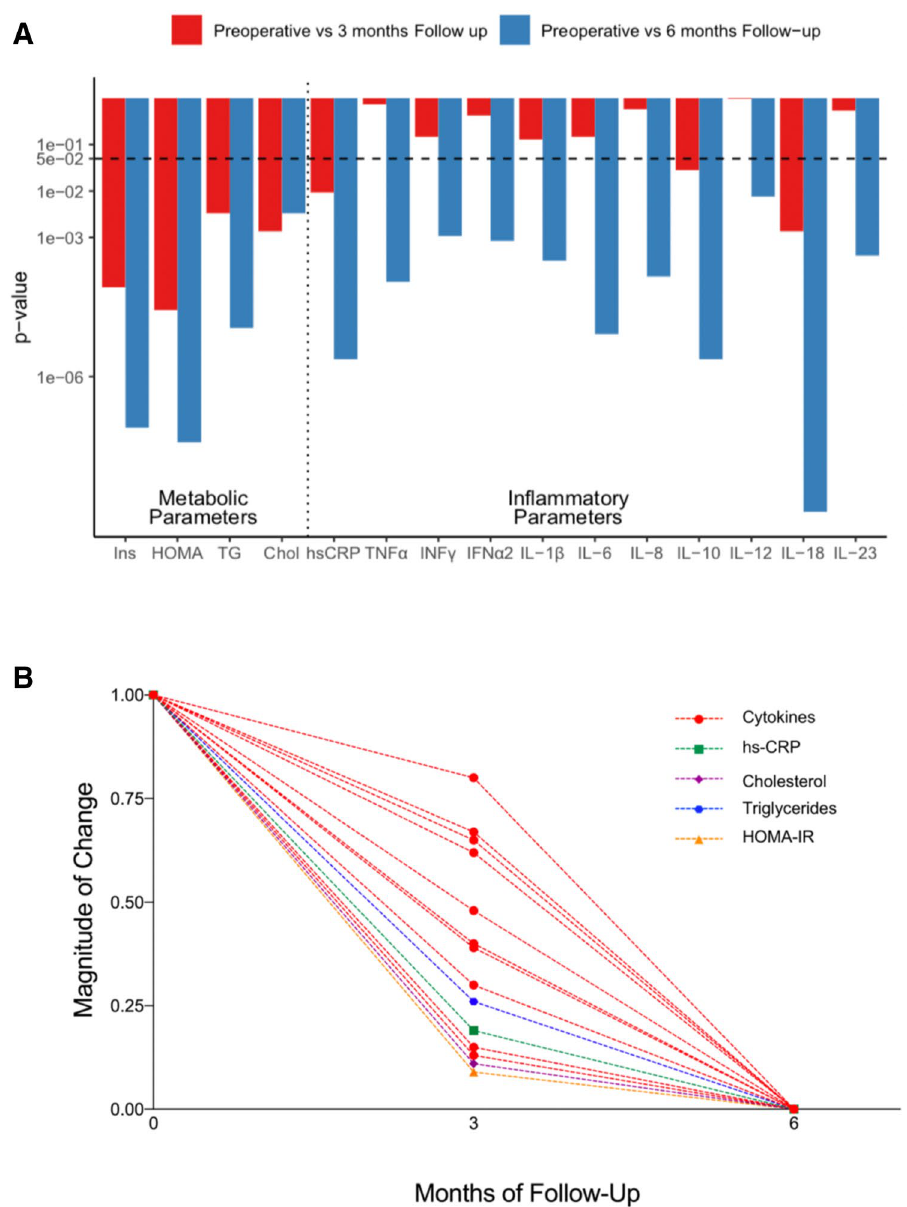
Figure 2. Metabolic normalization precedes resolution of systemic inflammation. ( A ) Comparison of the p-values of the metabolic and inflammatory markers at 3 and 6 months post-surgery versus preoperatory values. The dashed line represents the cut-off for statistical significance (p-value = 0.05). ( B ) Median values at each time point after normalization, represented as the magnitude of change in each variable. IFN: Interferon,